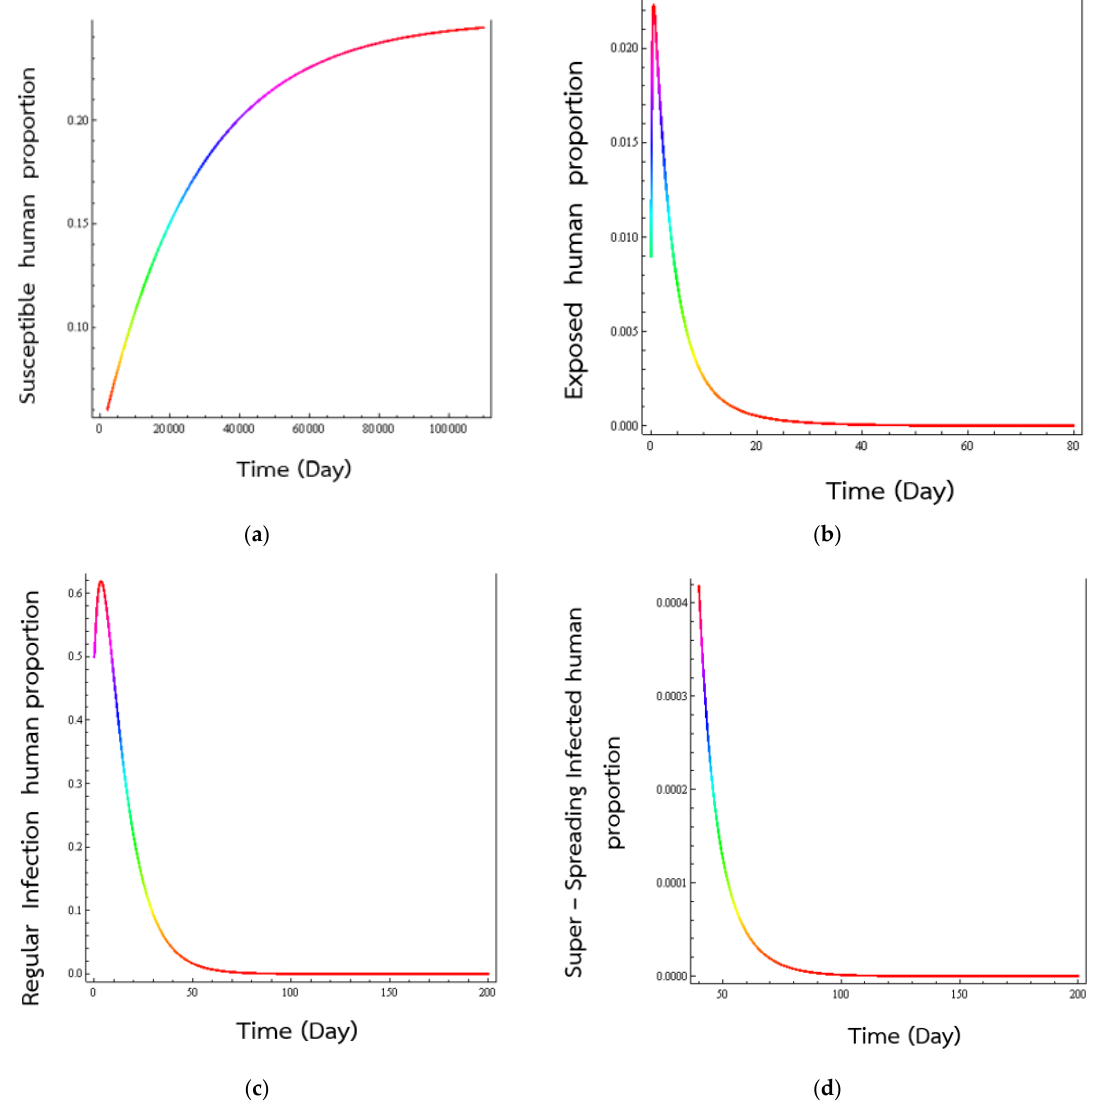
Figure 2. Numerical solution of systems (2.1)–(2.5), time series of ( a ) susceptible human population, ( b ) exposed human population, ( c ) normal infected humans, and ( d ) super-spreading infected humans. The numerical values of the parameters are listed in Table 1 and these are just possible values and have no significance. The simulated human populations converge to the disease-free state ζ ∗ when R 0 = 0.8302 <